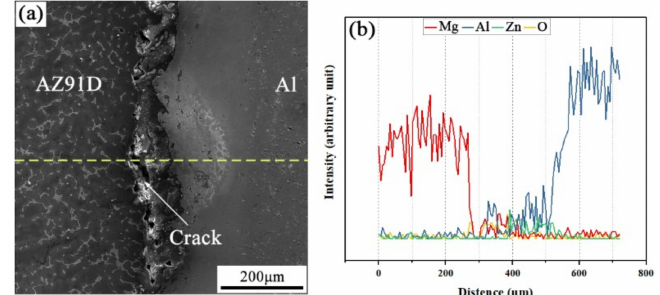
Figure 3. ( a ) SEM micrograph and ( b ) EDS line scan spectrum (marked as dashed line in ( a )) of the interface in the arc-sprayed Al / AZ91D bimetals with a Zn interlayer (arc-spraying Zn for 10 s and Al / Zn double-deck coating preheated for 6